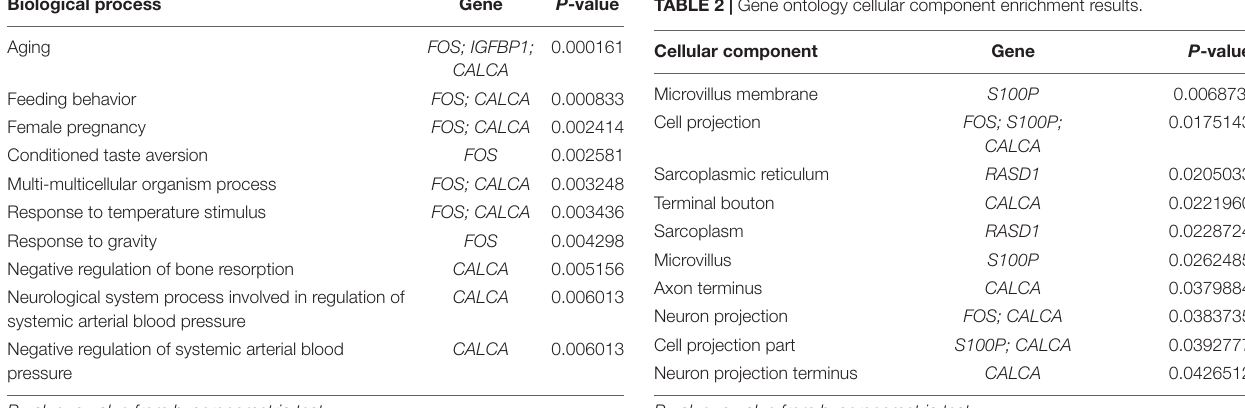
regard to GSE24807, after log2 transformation, the values of RNA expression in each sample became more concentrated, and this was more conducive for the screening of different genes.